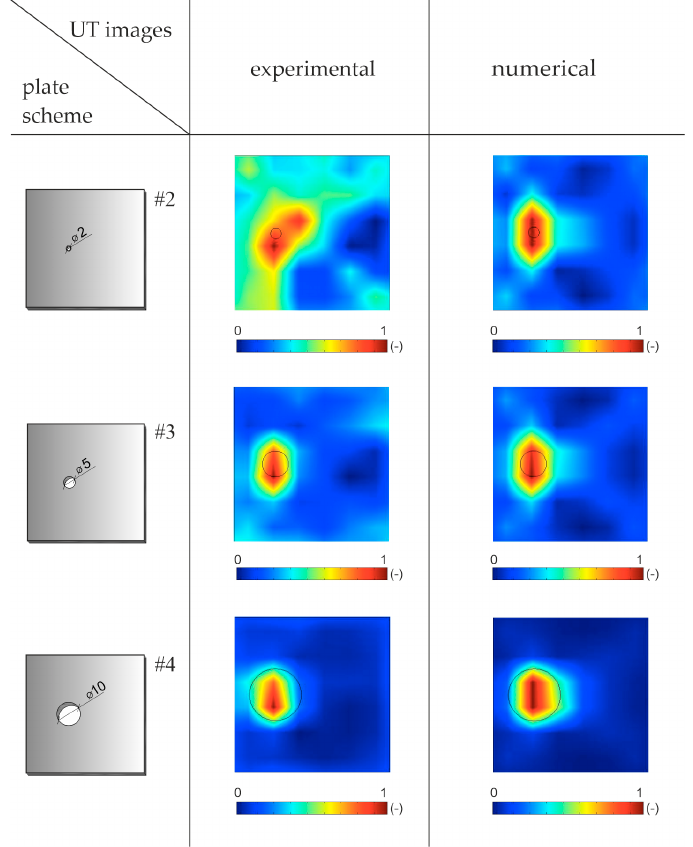
Figure 11. Ultrasonic tomography (UT) maps in plates with surface damage with the reference to the undamaged plate using TOF differences.